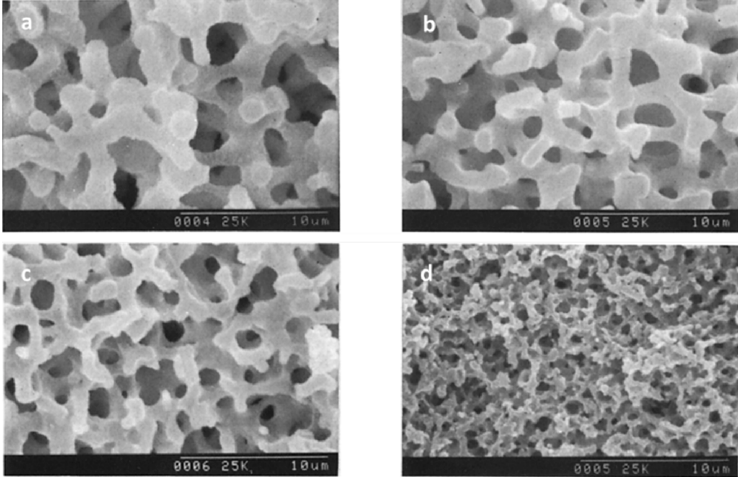
Figure 7. Scanning electron photomicrographs of dried gel morphology for increasing quantities of PEO (100,000 Mw), in a synthesis that involves 6.51 g of TEOS, 0.81 g f 60% aq. HNO 3 , and 8 g of H 2 O: ( a ) 0.30 g PEO; ( b ) 0.40 g PEO; ( c ) 0.50 g PEO; ( d ) 0.60 g PEO. Scale bar = 10 µm. Reprinted by